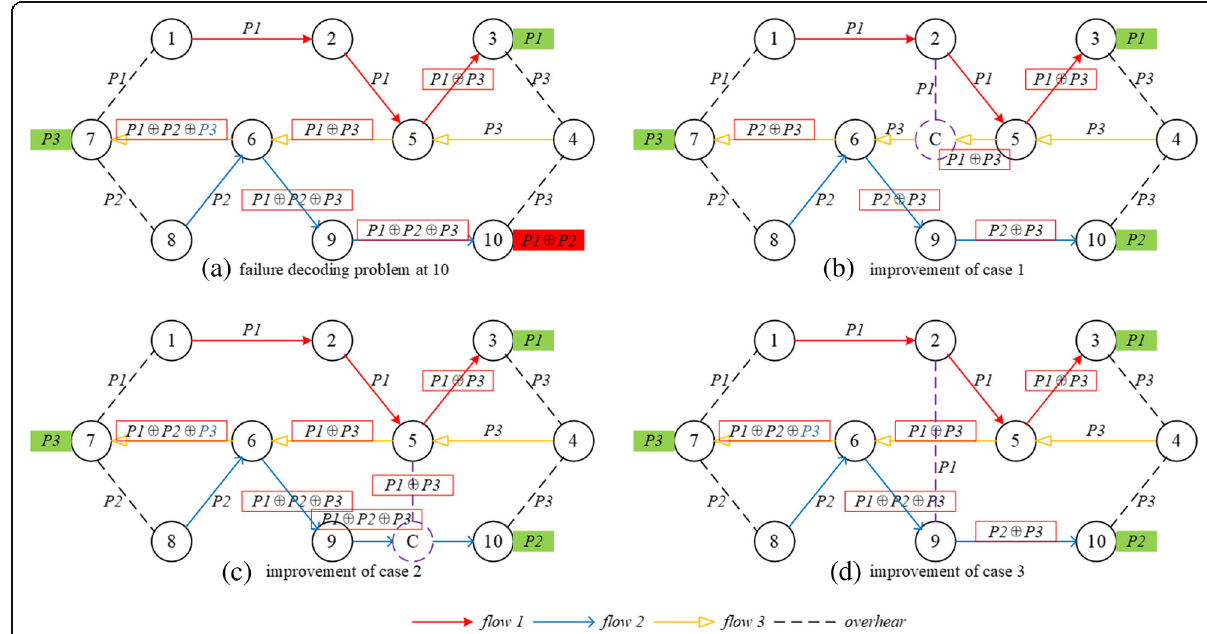
Fig. 5 Example of decoding failure and improvement for coding structure with multi-hop range in GCC. Figure 5 illustrates the decoding failure problem in MCC, and gives three improvements to solve the decoding failure problem. a Failure decoding problem at 10, b improvement of case 1, c improvement of case 2, and d improvement of case